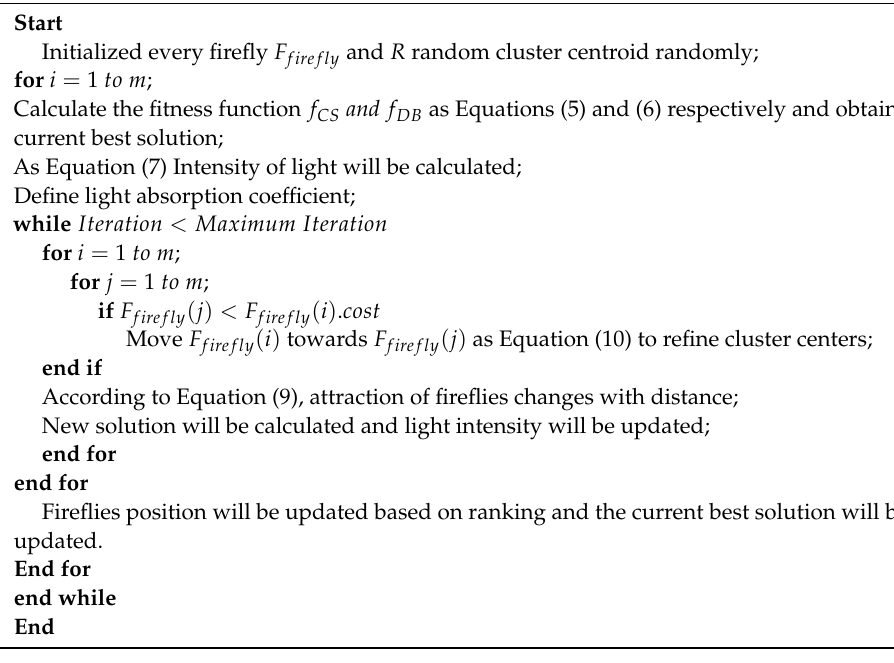
Algorithm 1 is data clustering using the FA algorithm. In this algorithm, the method by which clusters are encoded with FA algorithm is mentioned. Initially, every firefly and cluster centroid is initialized randomly. Then the fitness function is calculated as Equations (5) and (6). According to Equation (9), firefly attraction will be changed and the solution will be updated. Algorithm 1. Pseudo code for